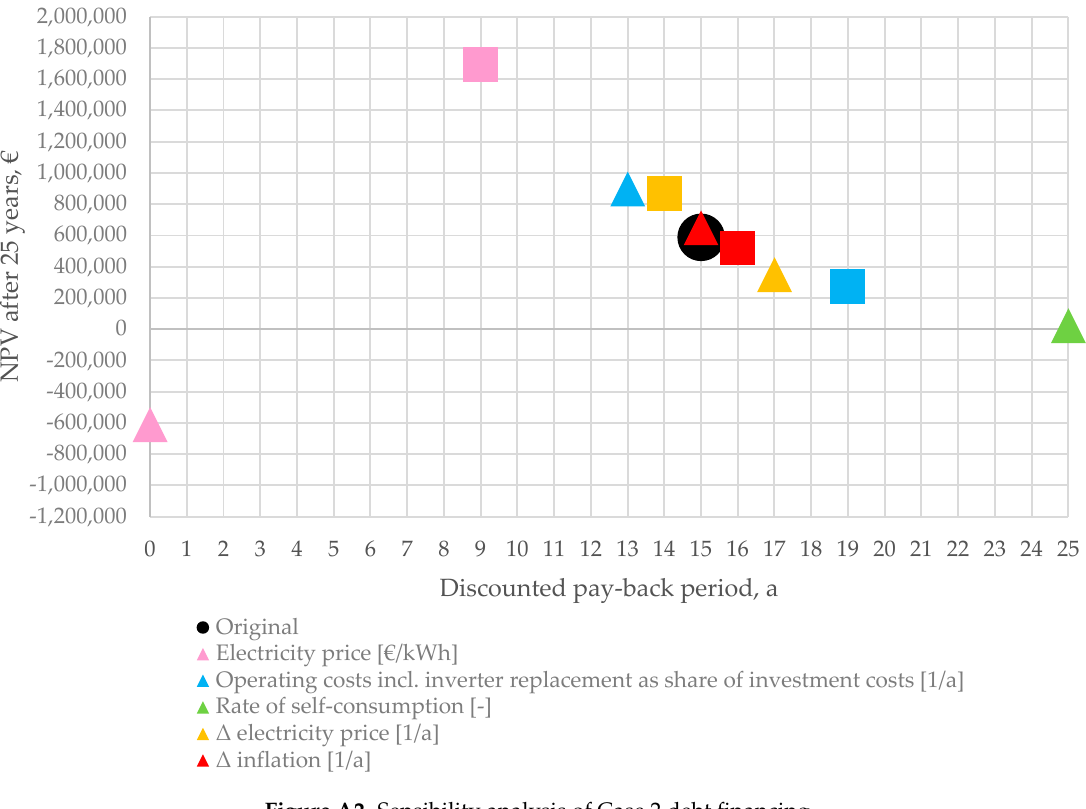
Figure A1. Sensibility analysis of Case 1 debt financing.